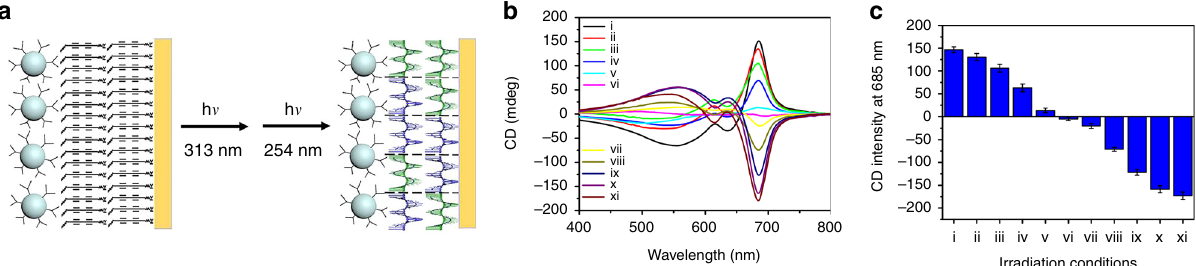
Fig. 3 Fine-tuning the degree of chiral asymmetry of PDA with sequential UV irradiation at 313 nm and 254 nm. a A mixture of left-handed and right- handed PDA obtained with sequential exposure of UV at two wavelengths. b CD spectra and c corresponding CD intensities at 685 nm of PDA obtained with different irradiation conditions: (i) 360 s at 313 nm, (ii) 340 s at 313 nm and 10 s at 254 nm, (iii) 320 s at 313 nm and 15 s at 254 nm, (iv) 300 s at 313 nm and 20 s at 254 nm, (v) 280 s at 313 nm and 25 s at 254 nm, (vi) 260 s at 313 nm and 35 s at 254 nm, (vii) 200 s at 313 nm and 40 s at 254 nm, (viii) 140 s at 313 nm and 45 s at 254 nm, (ix) 80 s at 313 nm and 50 s at 254 nm, (x) 20 s at 313 nm and 55 s at 254 nm, (xi) 60 s at 254 nm, respectively. At least four irradiation experiments were performed to obtain the average CD signals, and error bars represented standard deviations of measured CD